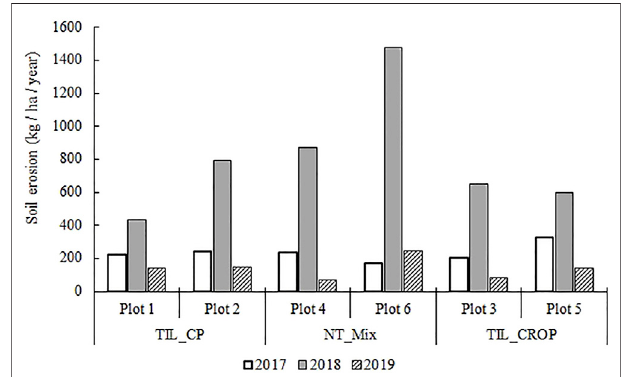
FIGURE 4 | Accumulated soil loss per plot and year (kg/ha).